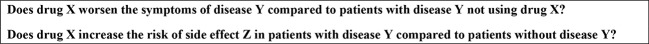
Key questions in drug-disease interactions.